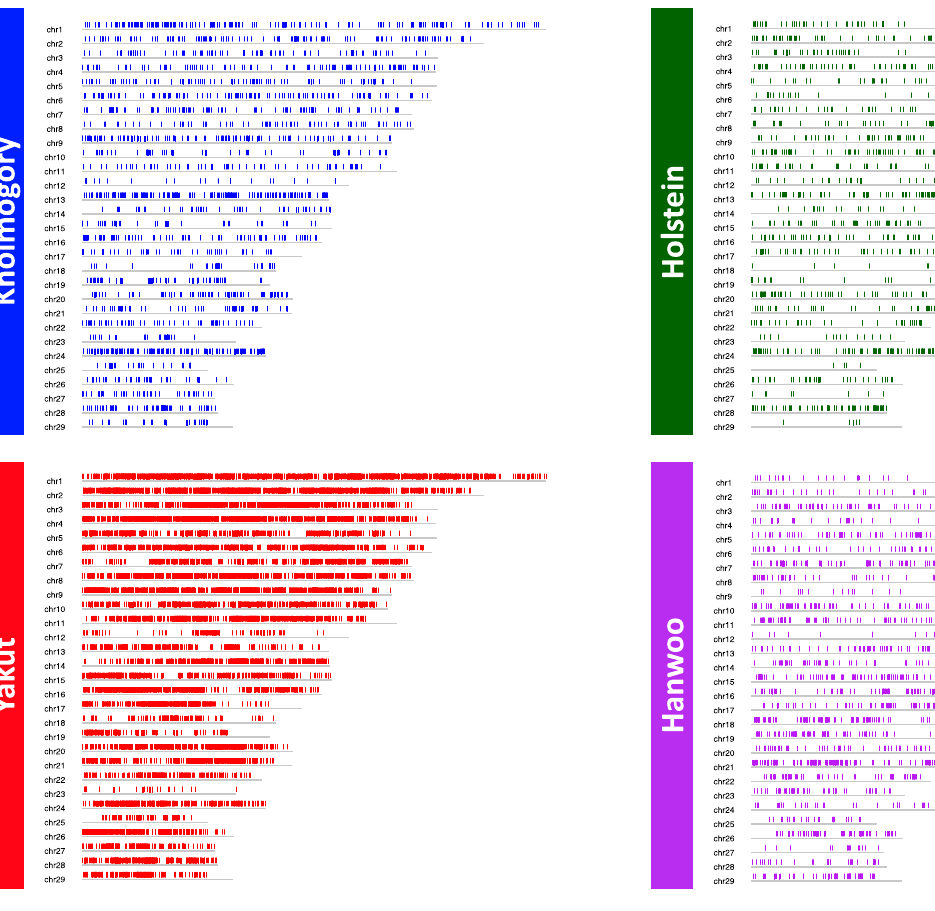
Figure 1. Whole genome distribution of breed-specific CNVRs for the four breeds.